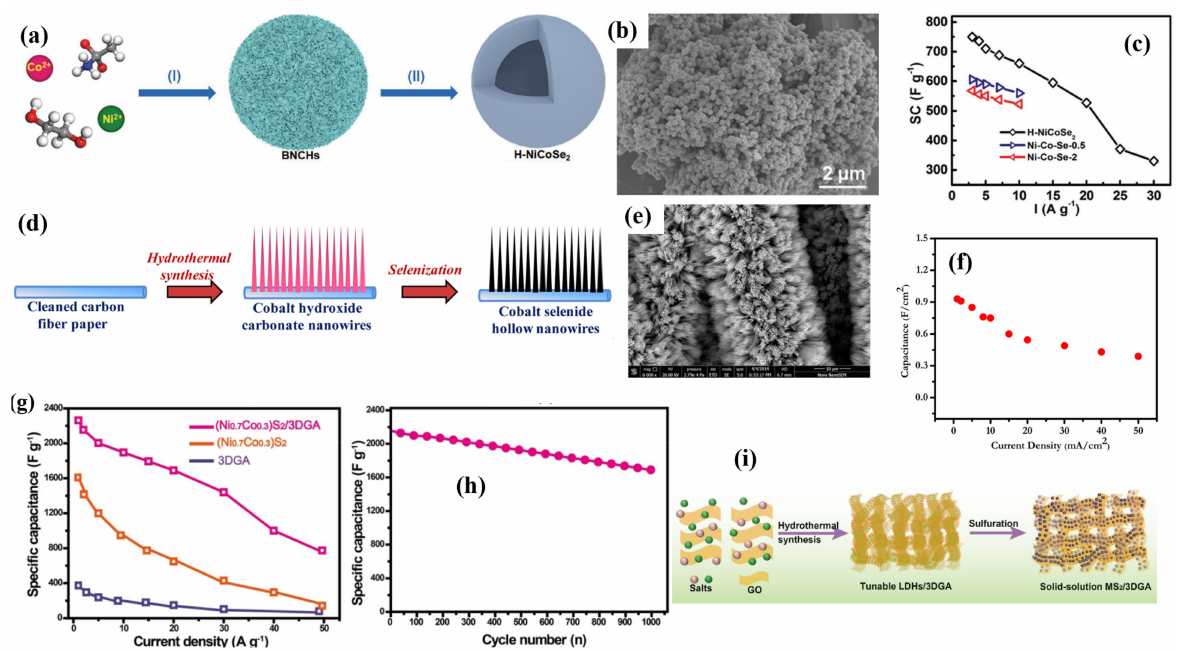
Figure 17. ( a ) Schematic preparation for the synthesis, ( b ) FESEM image of the H-NiCoSe 2 sub- microspheres. ( c ) Capacitance comparison vs. current density for different electrodes. Adapted with permission [349]. Copyright (2018) John Wiley and Sons. ( d ) Schematic illustration of the formation, ( e ) SEM image, and ( f ) The capacitance of the Co 0.85 Se HNWs. Adapted with permission [350]. Copyright (2014) American Chemical Society. ( g ) Capacitance comparison of different fabricated electrodes. ( h ) Specific capacitance as a function of cycle number ( i ) Schematics of the preparation process for the solid-solution MS 2 /3DGA composites. Adapted with permission [351]. Copyright (2017) American Chemical